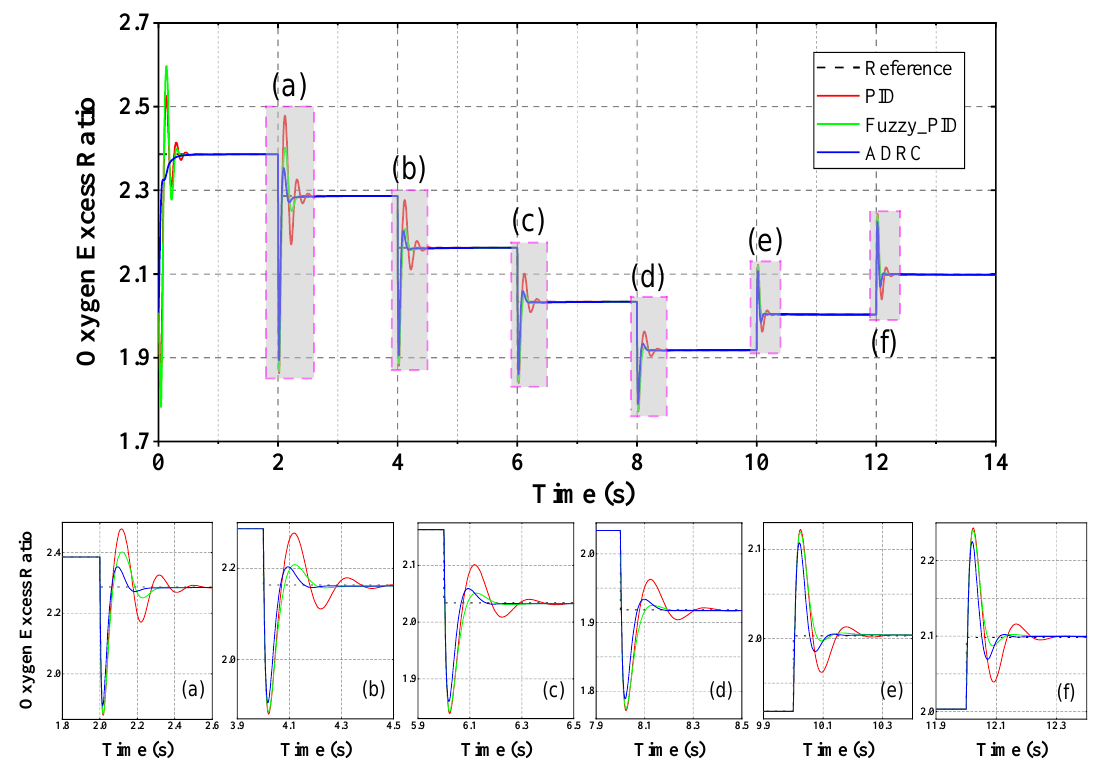
Figure 7. OER tracking curves under different control methods (( a – f ) is the enlarged view of the 2nd, 4th, 6th, 8th, 10th and 12th seconds respectively).